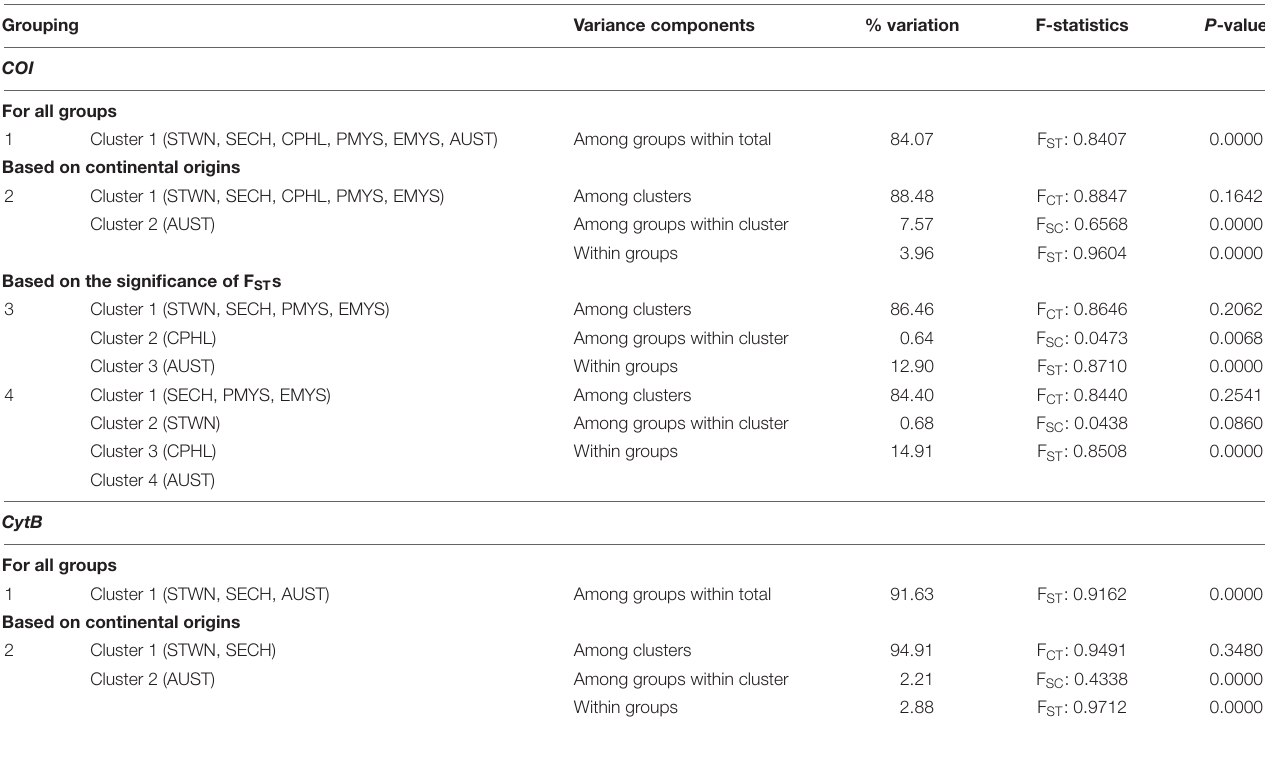
TABLE 4 | Analysis of molecular variance (AMOVA) results for hierarchical genetic subdivision for the percentage of variation and F-statistics of the cytochrome oxidase I (COI) and cytochrome B (CytB)